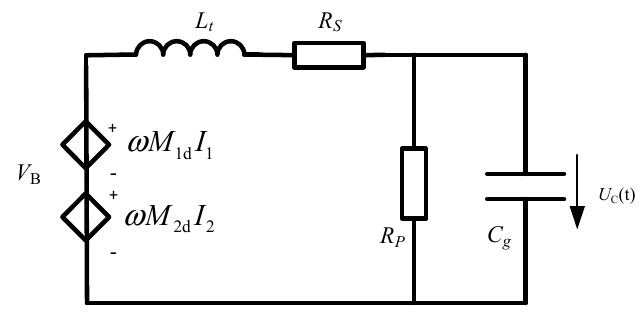
Figure 9. Equivalent circuits of the driving blocks.